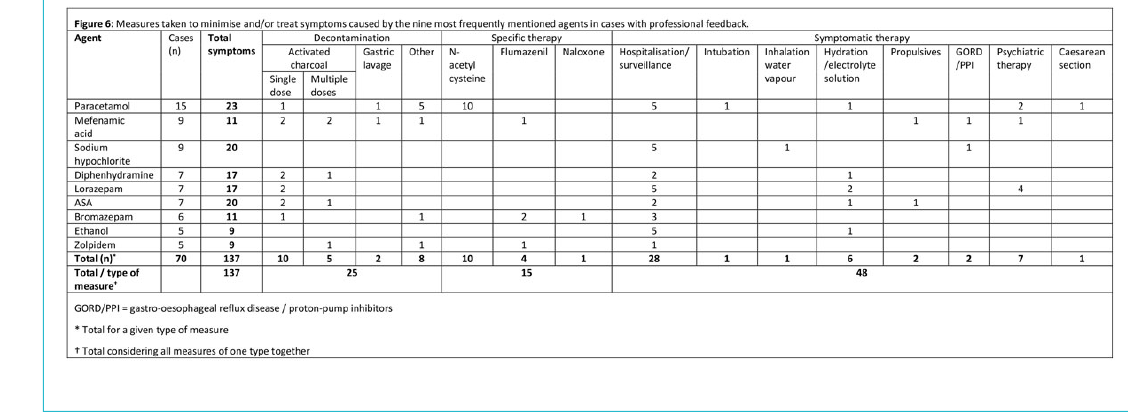
Figure 6: Measures taken to minimise and/or treat symptoms caused by the nine most frequently mentioned agents in cases with professional